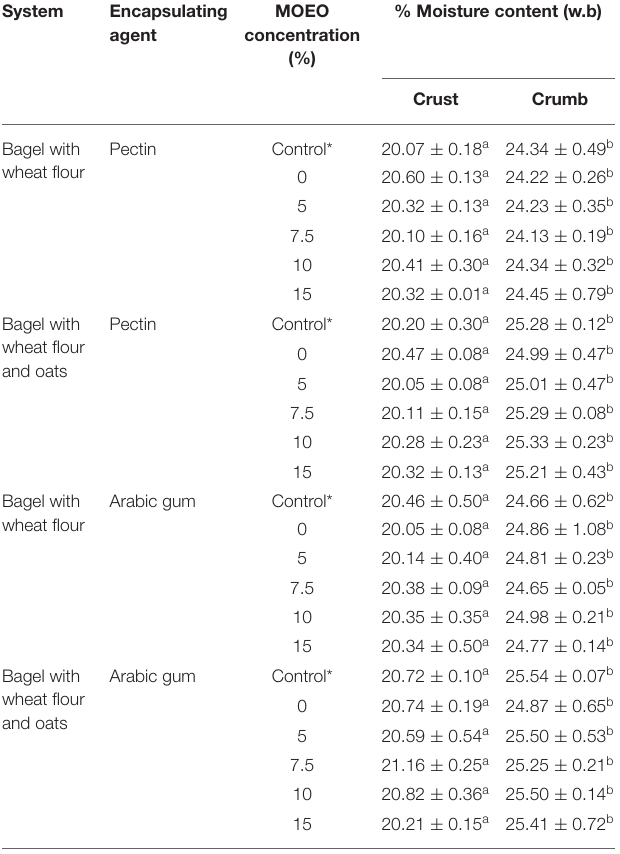
TABLE 5 | Percentage of moisture content (w.b.) of crust and crumb of different formulations of bagels atomized with emulsions stabilized with pectin or Arabic gum at different concentrations of Mexican oregano essential oil (MOEO) stored at 25 ◦ C. System Encapsulating agent